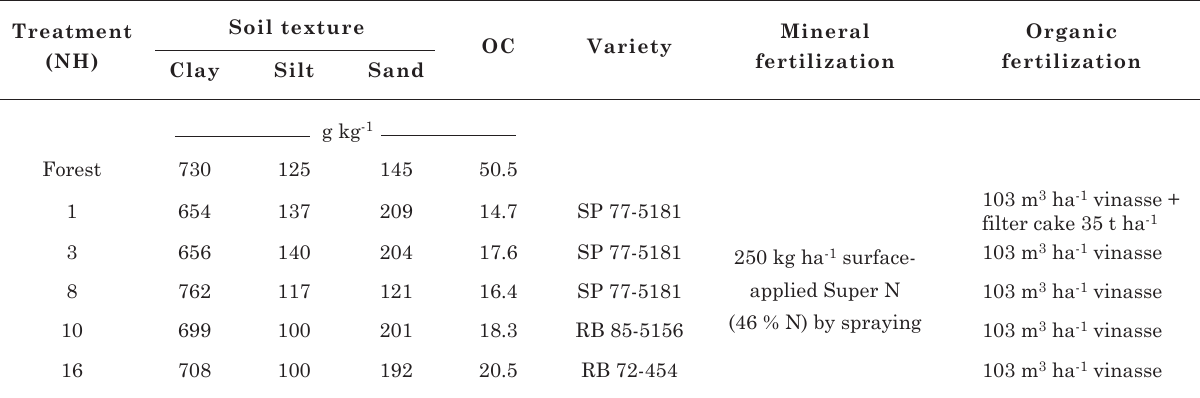
table 1. number of harvests (nh), clay content and organic carbon content (oc) in the 0–40 cm layer, varieties and fertilization applied in the plantations